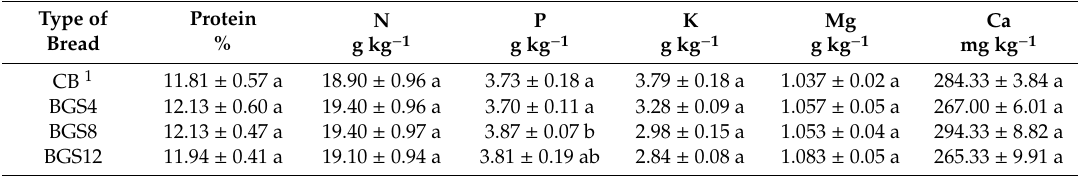
Table 3. The content of protein and macroelements in control bread and enriched breads.